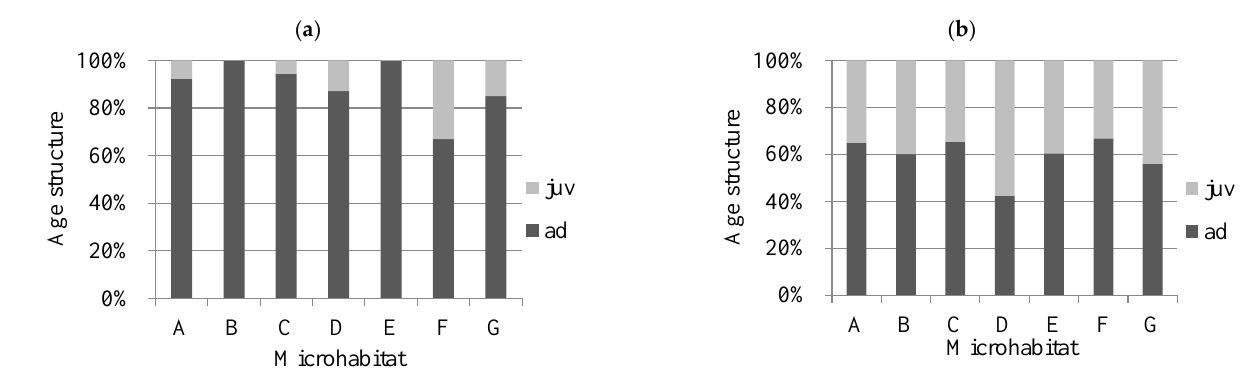
Figure 7. Age structure of Oribatida ( a ) and Mesostigmata ( b ) in microhabitats of broadleaf forest in Eastern Norway: A — moss on ground, B — lichens on tree twigs lying on ground, C — moss on tree trunks at ground level, D — moss on tree trunks 1.5 m above ground, E — moss on decaying stump, F — moss on decaying log, G — decaying wood from trees: ad — adults, juv — juveniles.